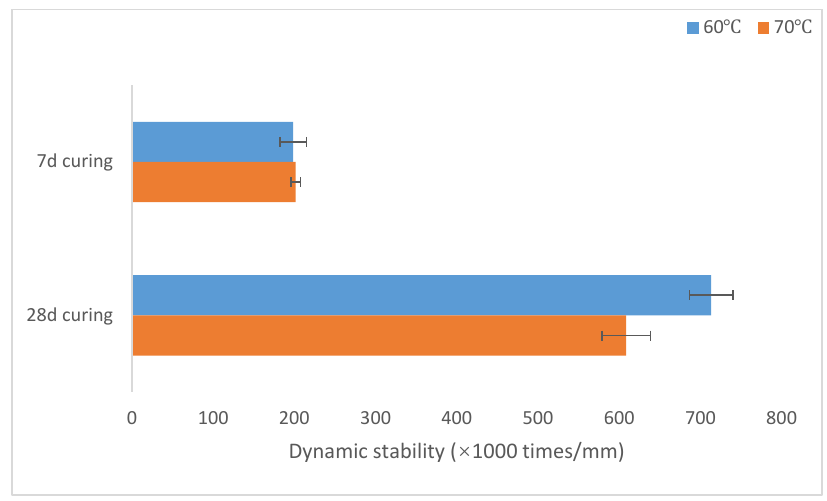
Figure 5. Dynamic stability test results at different test temperature and curing times.